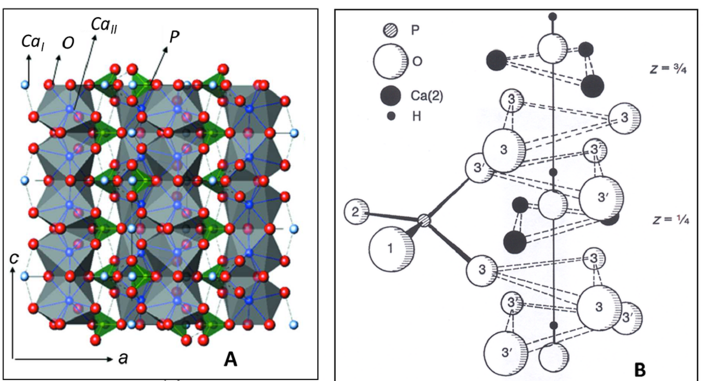
Figure 1. ( A ): Crystallographic structure of HAp with a hexagonal unit cell a = 0.9432 nm, c = 0.6881 nm [14]. Blue spheres: Ca 2+ ; green spheres: P 5+ ; red spheres: O 2 − . Ca I O 9